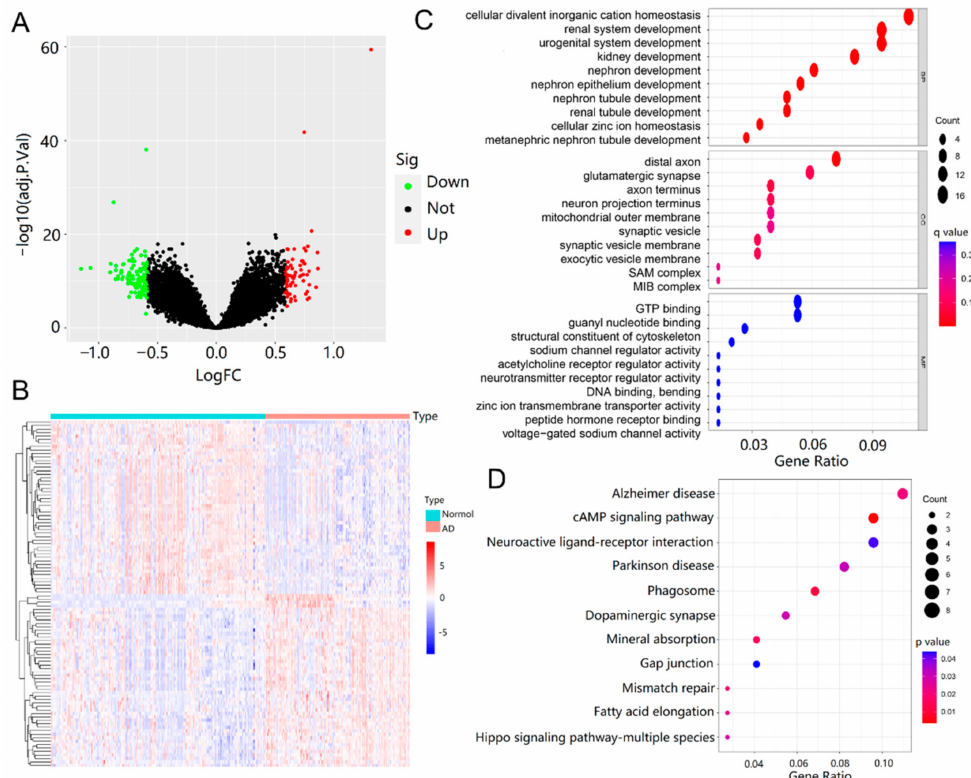
Figure 4. Screening and functional enrichment analysis of DEGs. ( A ) Volcano plot of DEGs (|log2FC| > 0.585 and FDR < 0.05). Up-regulated genes are colored in red and down-regulated genes are colored in green. ( B ) Heatmap of top 70 up and top 124 down DEGs of AD. ( C ) GO enrichment analysis of DEGs ( p < 0.05 and q < 0.05). ( D ) KEGG pathway enrichment results for DEGs ( p < 0.05 and q <